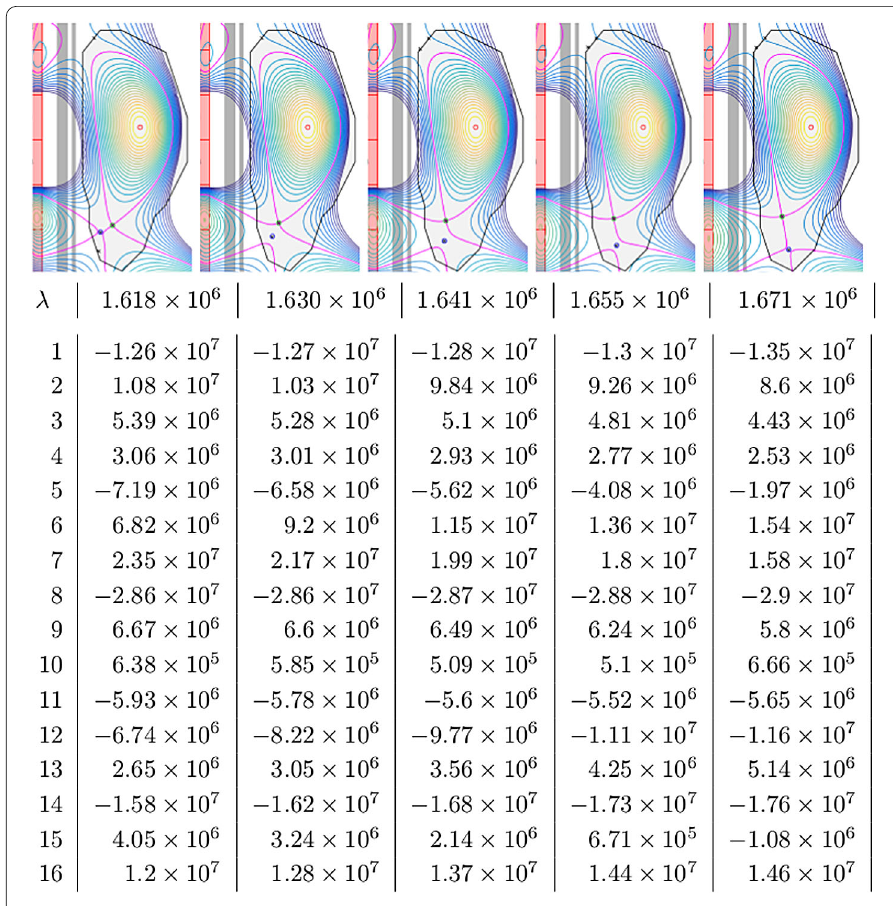
Figure 15 Results (C). The poloidal flux contour lines (top) and the 16 coil currents (bottom) in Ampère turns for the solutions of the optimal control problem (16) with objective functional C ( y ;1000, x 0 ) and x 0 = (5.02,–4.22), (5.22,–4.42), (5.42,–4.62), (5.62,–4.82), (5.82,–5.02) (from left to right) is indicated by the blue circle